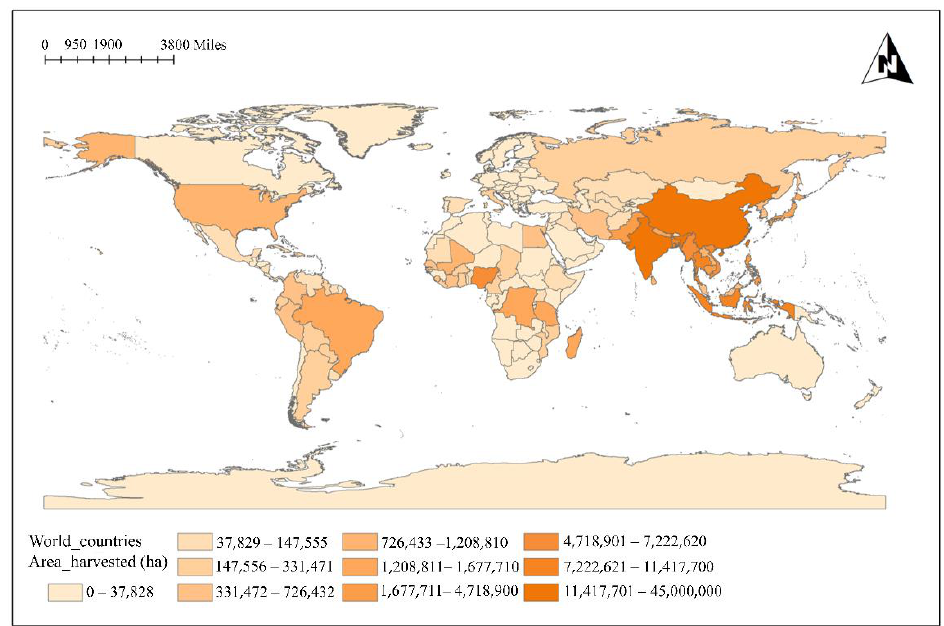
Figure 4. Global rice-harvesting areas of 2020 (Note: the data was collected from the Food and Agriculture Organization (FAO) website).